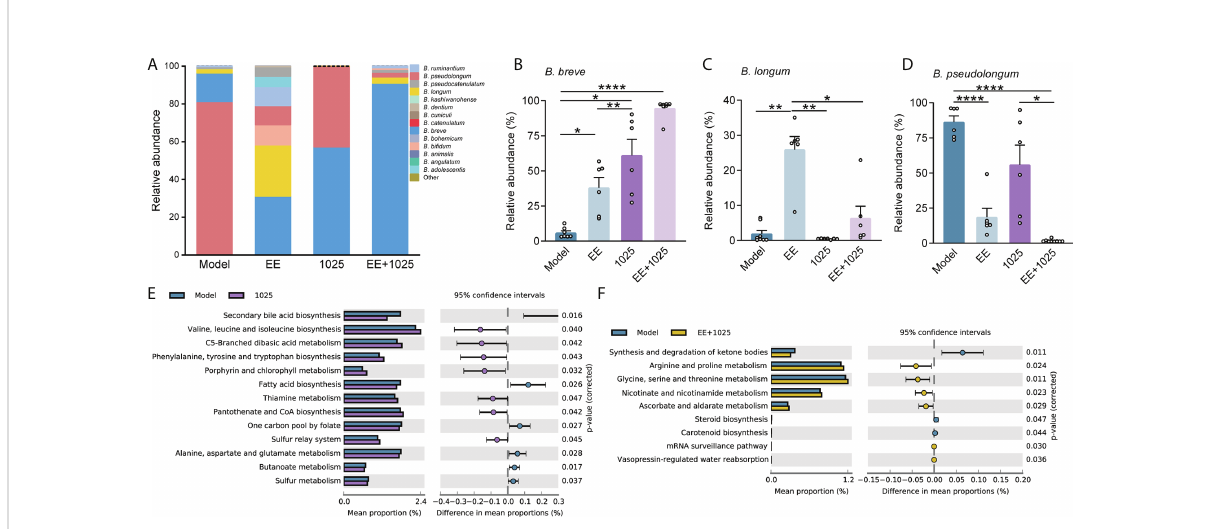
FIGURE 5 EE combined with B. breve CCFM1025 treatment alters the Bi fi dobacterium spp. and affects the gut microbiome on functional level. (A) Distribution of Bi fi dobacterium species in the Bi fi dobacterium genus (n = 6). (B – D) The relative abundance of B. breve , B. longum and pseudolongum (n = 6). Data are presented as mean ± standard error of the mean (mean ± SEM). Each data point represents one independent mouse. * P < 0.05, ** P < 0.01, **** P < 0.0001 as determined by one-way ANOVA. (E) Differential microbial functions between model and CCFM1025 groups. (F) Differential microbial functions between model and EE+1025 treated groups. Statistical difference of the gene contents between the two groups is screened by Welch ’ s-t test with P <